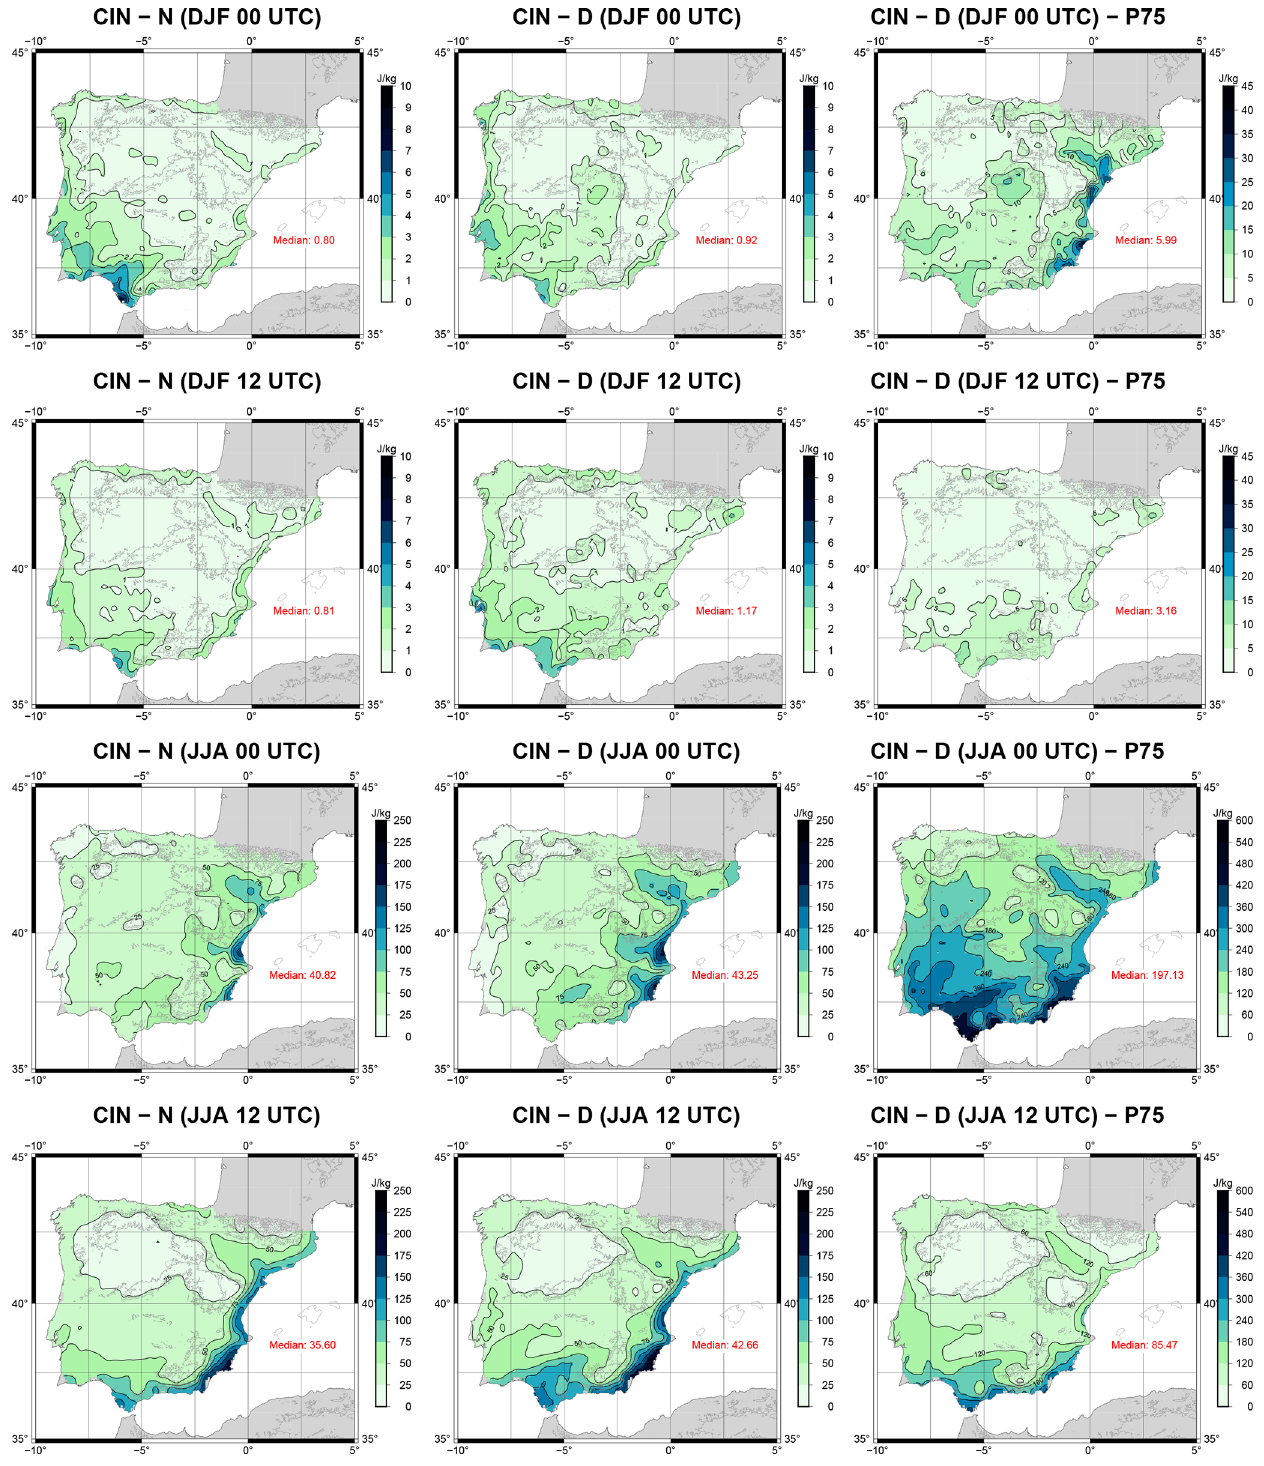
Figure 10. Same as Figs. 8 and 9 but for CIN. The rightmost column (P75) shows the mean of CIN in the D experiment during those days on which CAPE is higher than or equal to its third quartile at every grid